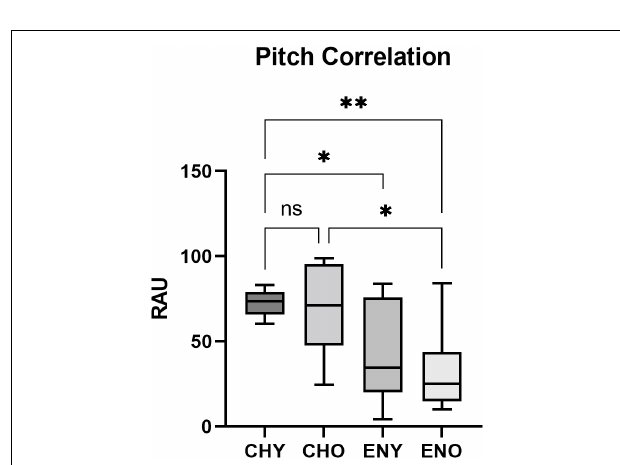
FIGURE 3 | Pitch Strength of the four groups. Pitch Strength in RAU values obtained from all four groups, elicited by/yi4/. Boxes represent the interquartile ranges with whisker bars indicating the data ranges. Number of asterisks indicate levels of statistical significance between groups ( p < 0.05, p < 0.01 and p < 0.001, respectively).